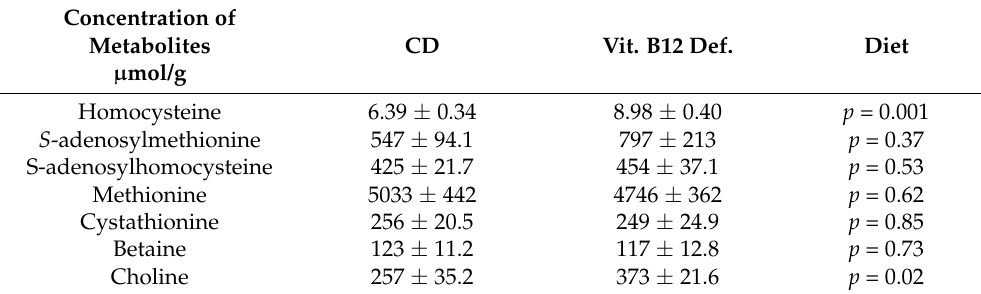
Table 2. One-carbon metabolite concentrations in liver tissue of control and vitamin B12 deficient diet females 1